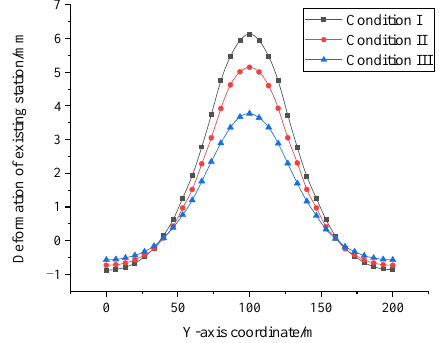
Figure 8. Floating curve of existing station.